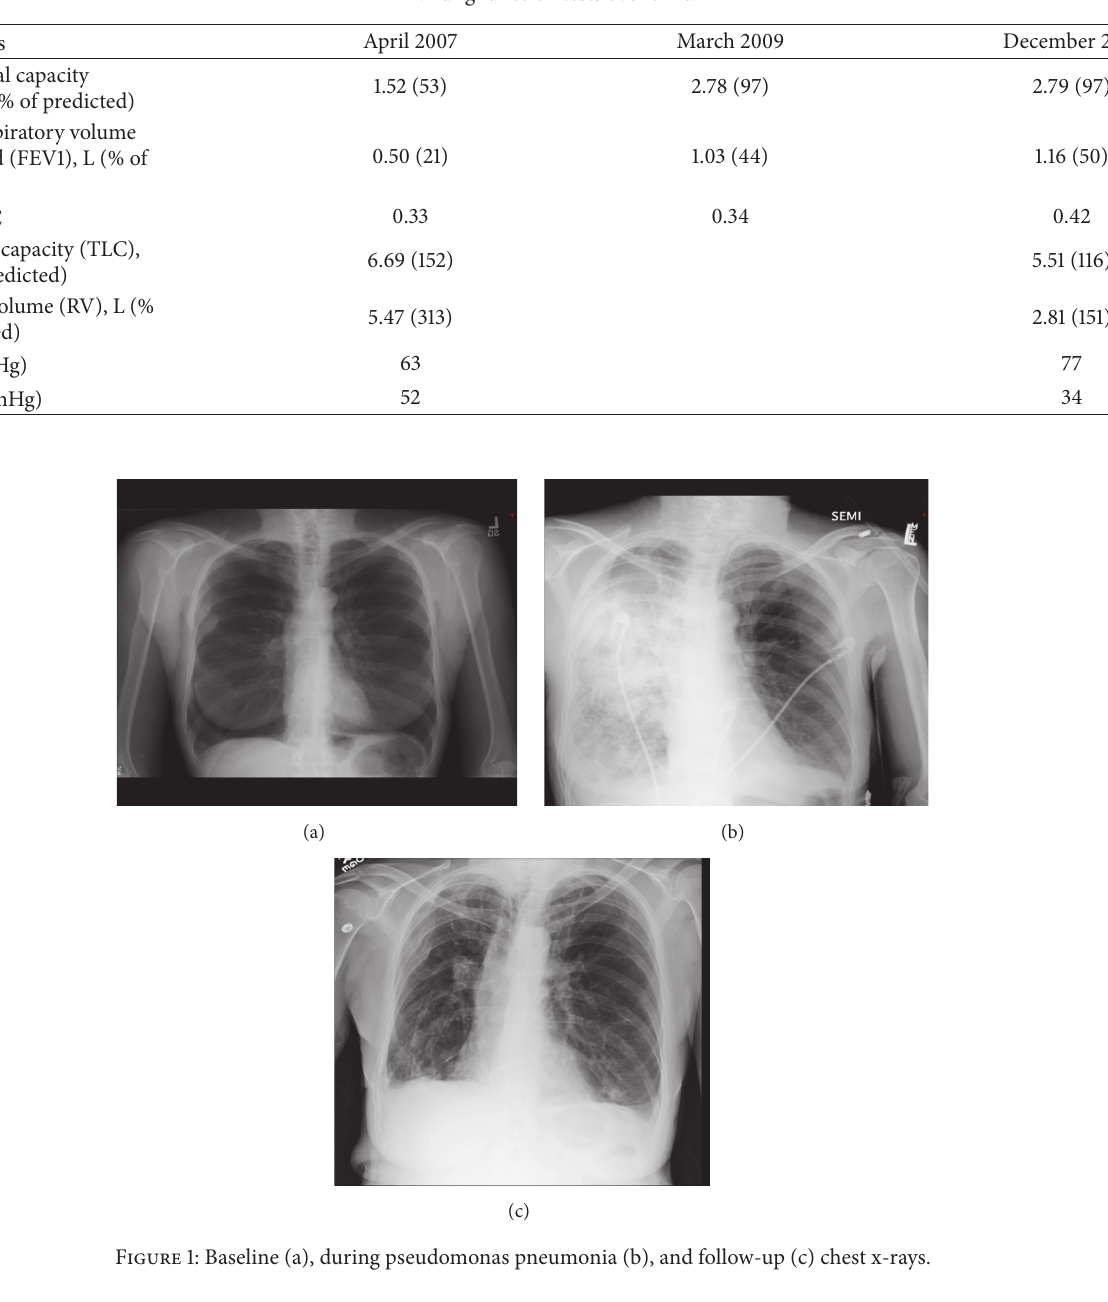
Table 1: Lung function tests over time.